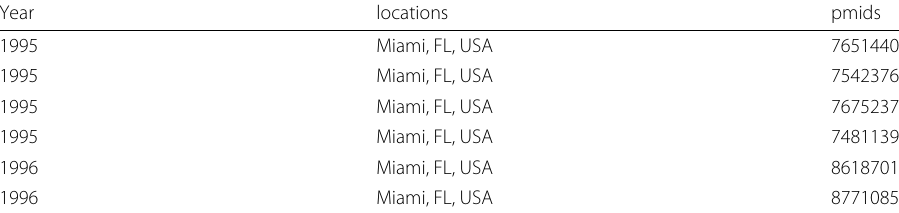
Table 3 Example of career path of a specific author (Lisa M. Shulman). For each record we have the year of publication, the city of the affiliation and the relative PubMed ID identifying the paper. The algorithm would record a move from Miami to Baltimore in 2001 and no moves in any other